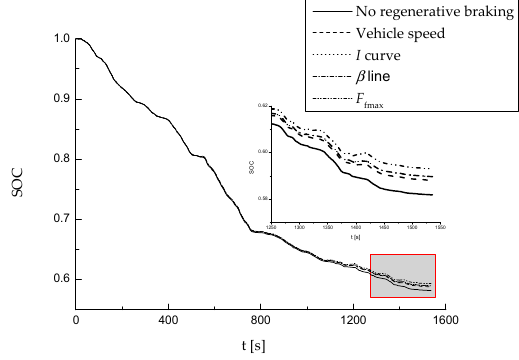
Figure 12. Comparison of SOC changes at road drive cycle.